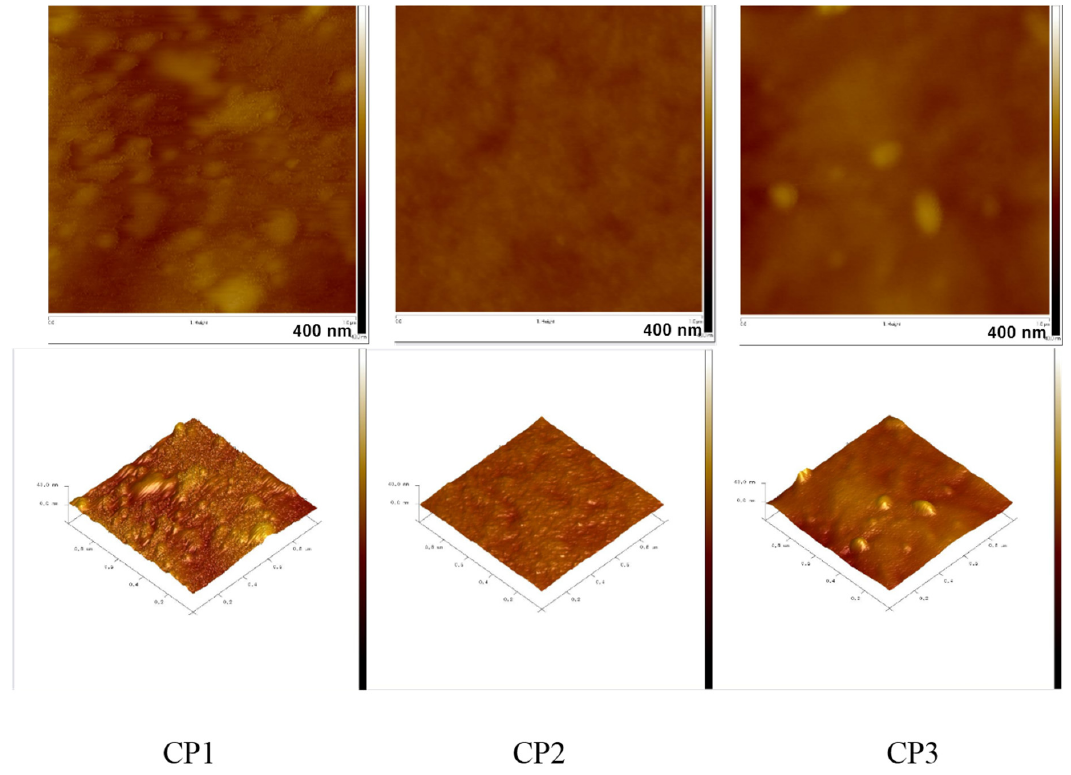
Figure 8. AFM images of copolymers.